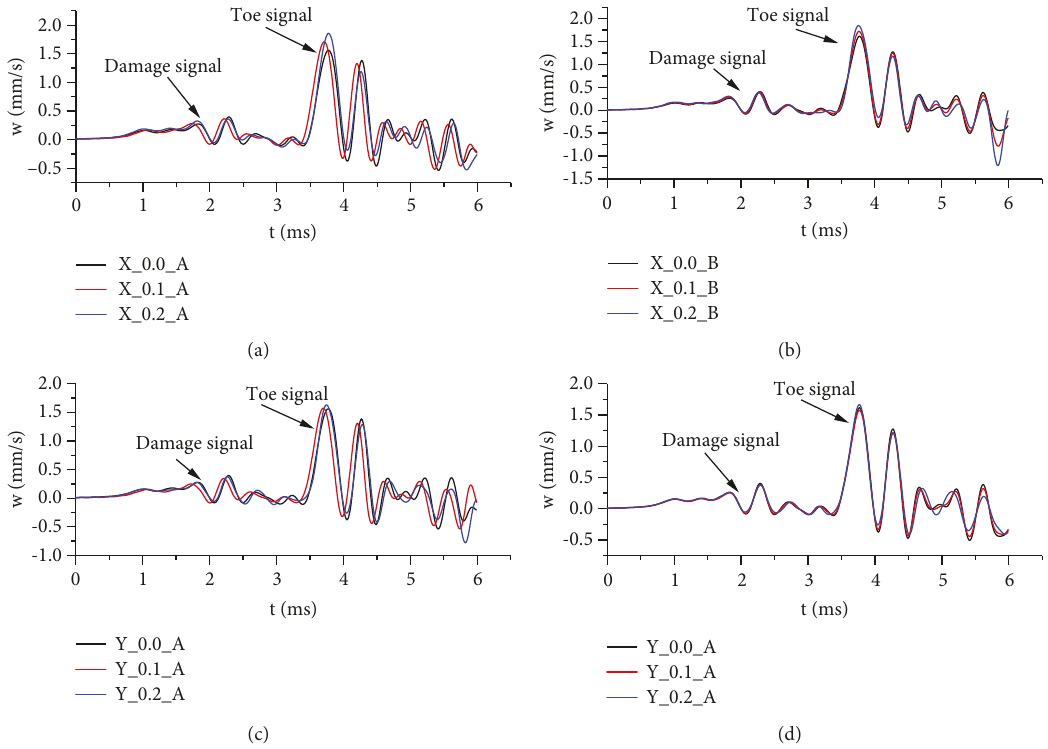
Figure 17: Upward velocities of different impact locations (sensor location Z 0.1, 0.2 m). (b) Upward velocities of B i (impact location x − − 0.2m). (d) Upward velocities of B i (impact location y